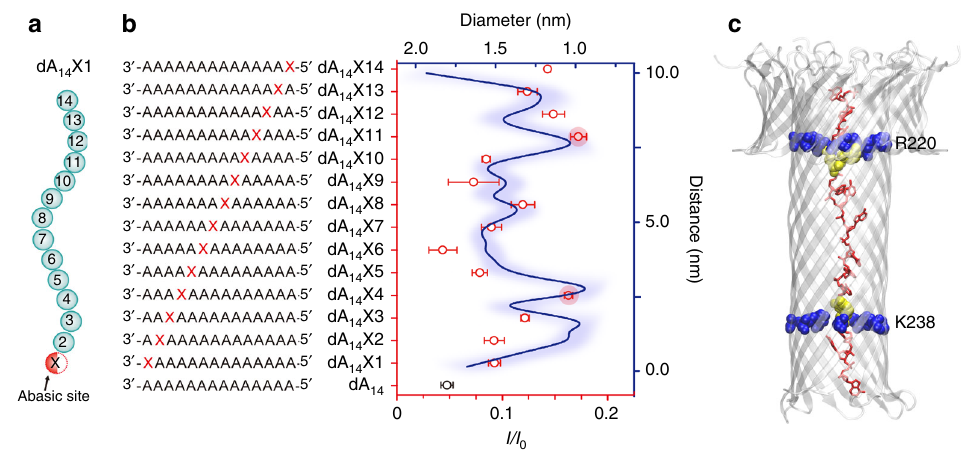
Fig. 3 Mapping the sensing spots of aerolysin by abasic site scanning of dA 14 . a Schematic representation of dA 14 X1 oligonucleotide; the red sphere of X represented the single-nucleobase deletion. b Comparison between the percentage of increase in residual current for each abasic oligonucleotide (red circle with error bar) and the pore diameter (blue line) calculated by the PoreWalker server. Data were obtained in 1.0 M KCl, 10 mM Tris, and 1.0 mM EDTA, pH = 8.0, 24 ± 2 °C at the bias potential of + 140 mV. The errors of the data were based on at least three separate measurements. c Selected MD snapshot of dA 14 fully inserted in the pore, showing the two main constriction points (R220 and K238, in blue van der Waals representation) and the DNA in red, with bases at positions 11 and 4 in yellow van der Waal